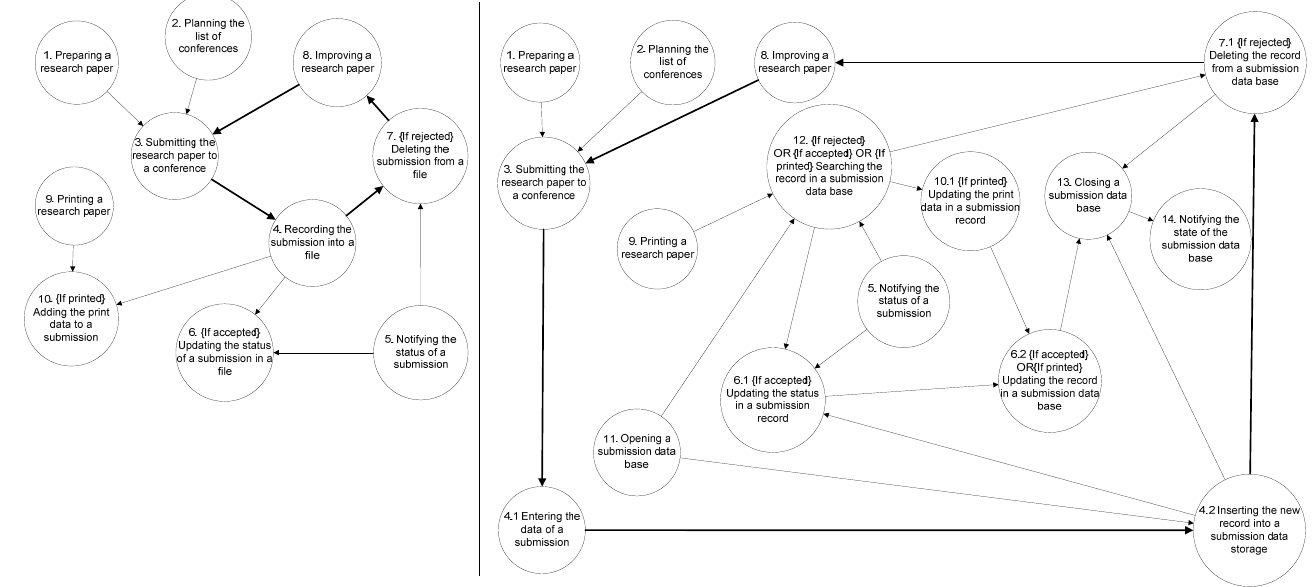
Fig. 4. The TFM of the system “AS IS” (on the left side) and the TFM of the system “TO BE” (on the right side). Data objects map to objects O or results R of TFM functional